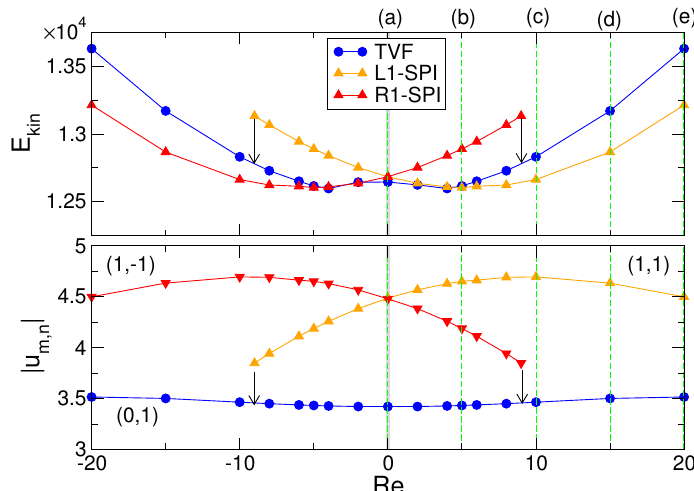
Figure 2. Influence of an external through-flow Re in absence of radial flow ( α = 0) on different vortex structures. Shown are top modal kinetic energy E kin and bottom primary Fourier amplitudes of the radial flow field at midgap r = 0.5 for L1-SPI ( u 1,1 ), R1-SPI ( u 1,1 ), and the TVF ( u 0,1 ). The dashed lines and letters (a–e) on top of the panel indicate the Re number at which bifurcation scenarios with variation in α are plotted in Figure 3. Vertical arrows indicate transitions after loss of stability, see text for